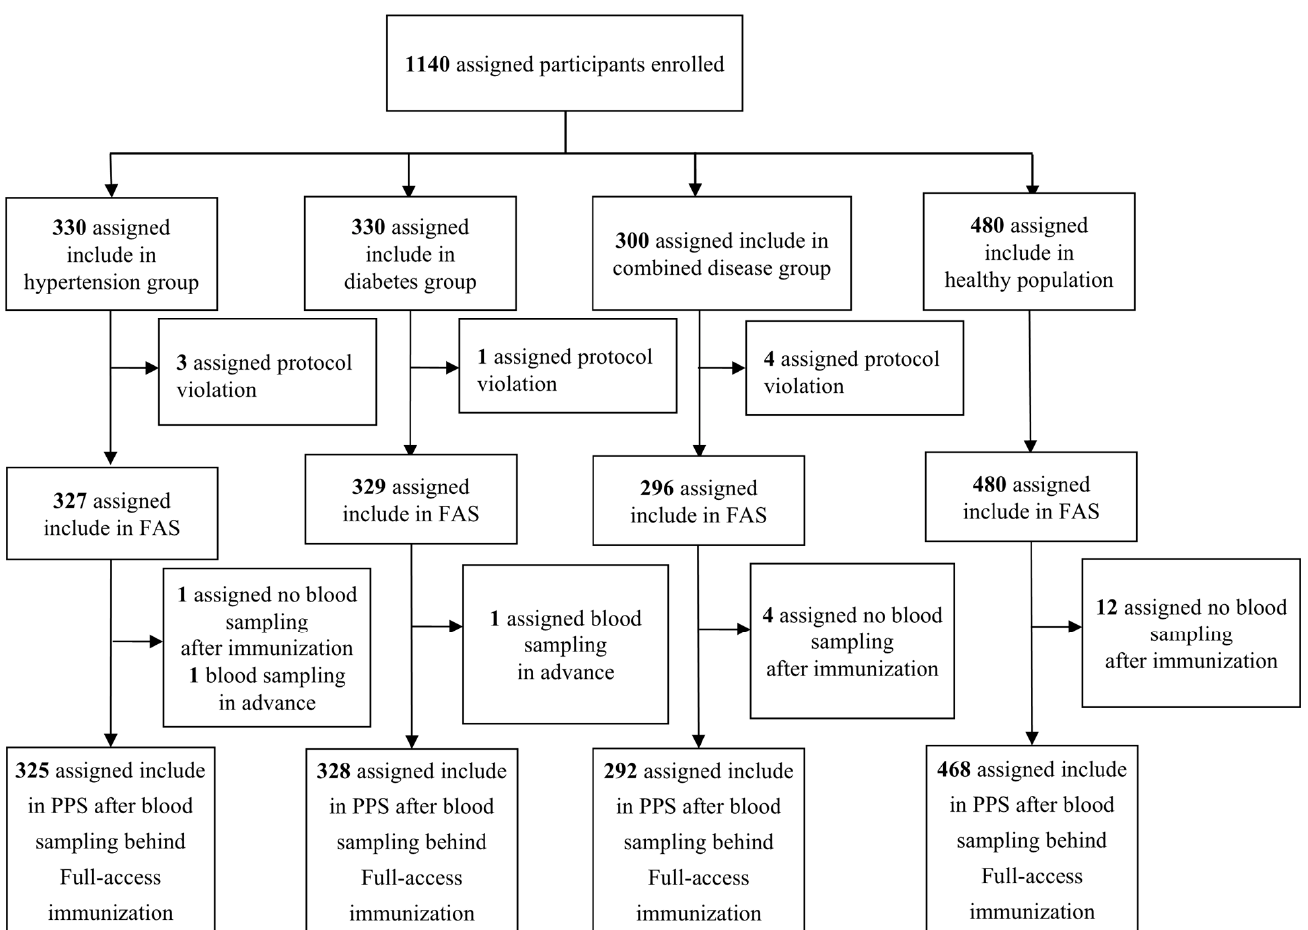
Figure 1. Screening and Enrollment of Participants. A total of 1440 study participants were enrolled in this study. A total of 1432 study participants were included in the safety analysis data set. A total of 1413 study participants were included in the immunogenicity analysis data